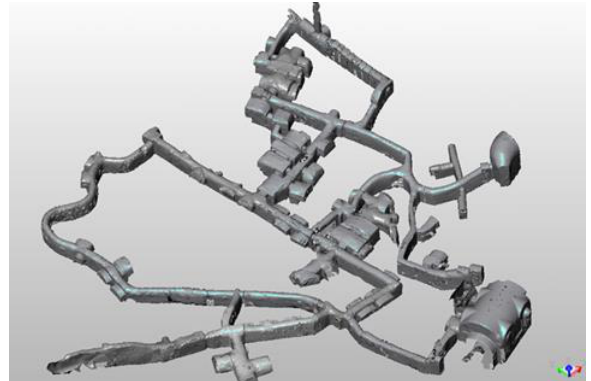
Fig. 11. Solid model of the Kyiv Pechersk Lavra caves